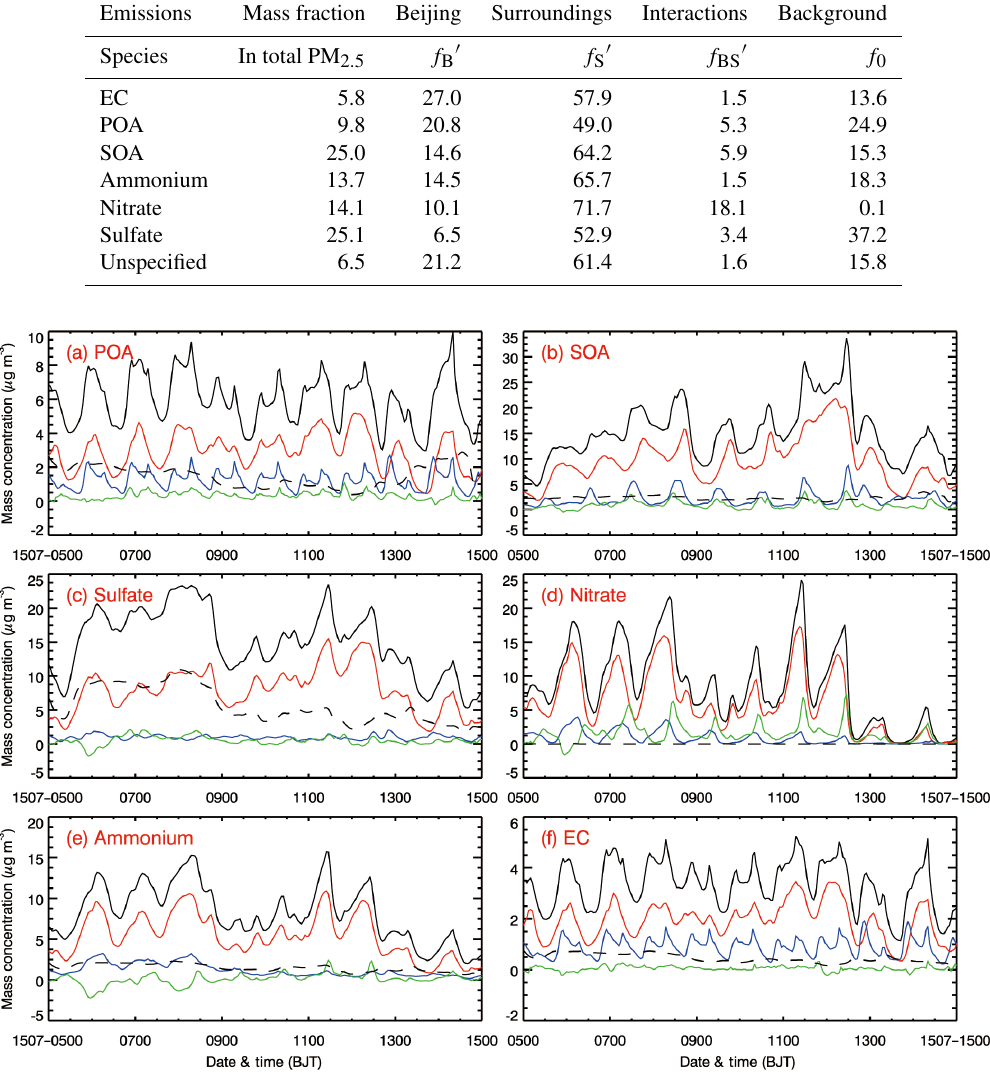
Figure 11. Temporal variations of the average contributions to the near-surface aerosol species concentrations from total emissions (black line, defined as f BS ) , local emissions (blue line, f B (cid:48) , defined as f B − f 0 ) , non-Beijing emissions (red line, f S (cid:48) , defined as f S − f 0 ) , the emission interactions (green line, f BS (cid:48) , defined as f BS − f B − f S + f 0 ) , and background (black dashed line, defined as f 0 ) in Beijing from 5 to 14 July